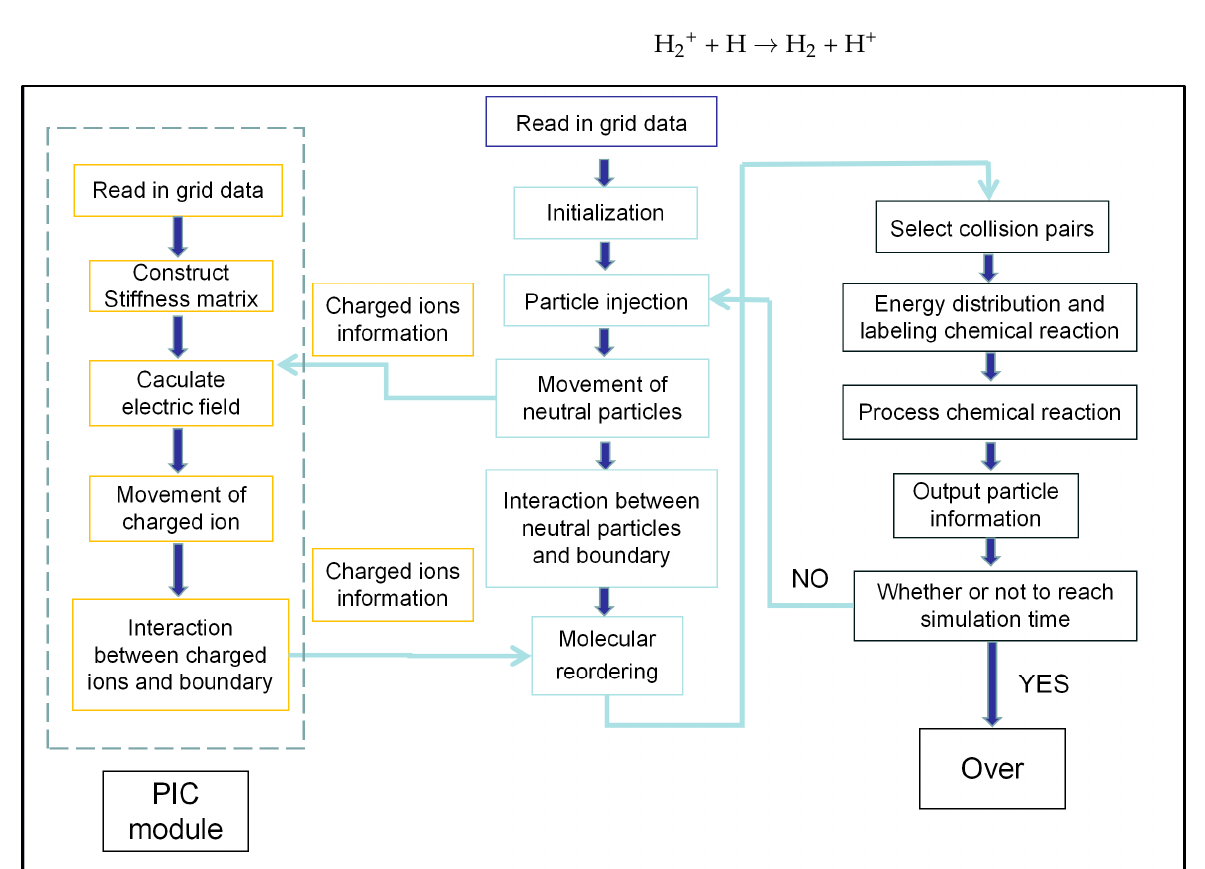
Figure 1. Flowchart of the hybrid DSMC/PIC algorithm.